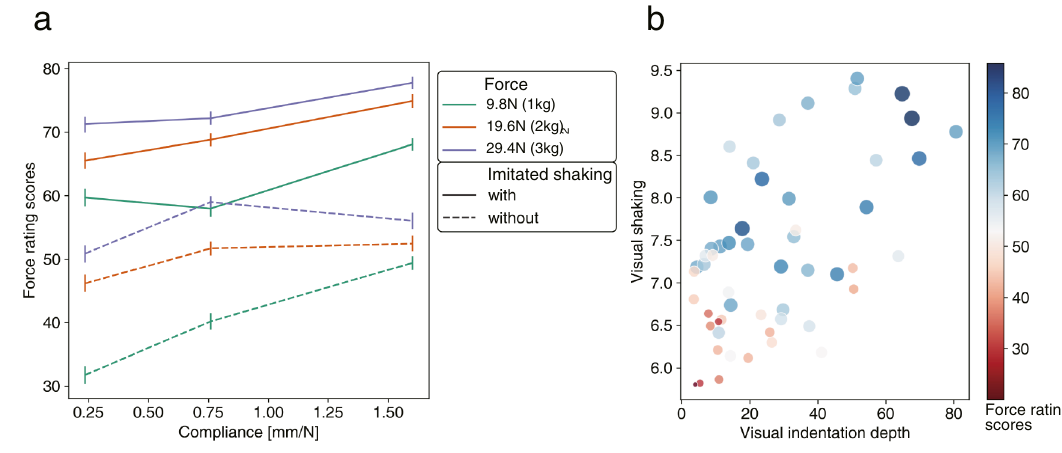
Figure 3. (a) Force rating scores for force, material compliance, and imitated shaking conditions. Error bars denote 95%CI. (b) Force rating scores for visual indentation depth and visual